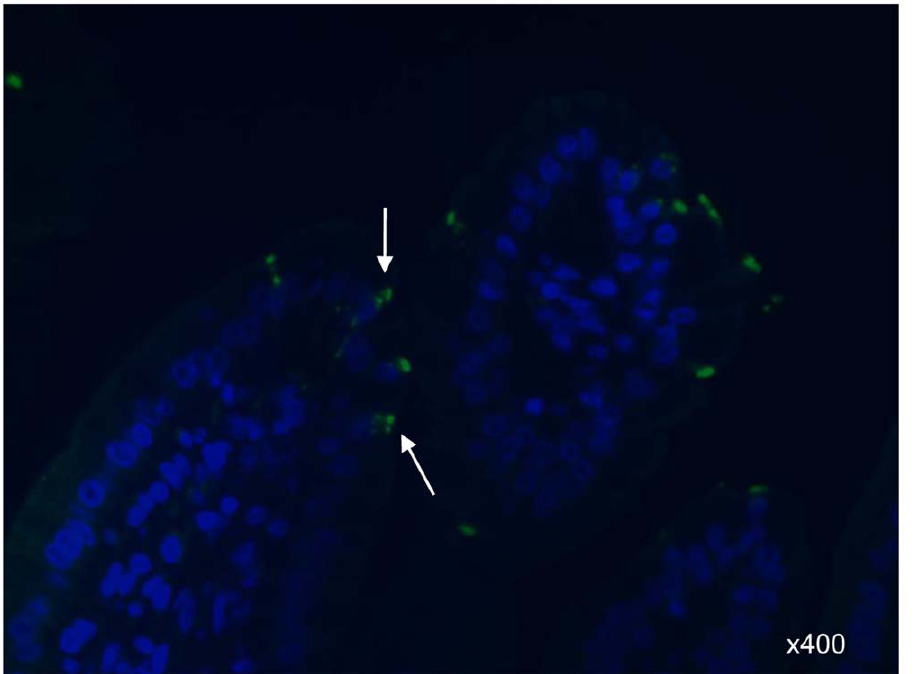
Figure 3. Fecal shedding coincides with IHC evidence for human NoV replication in the intestine. Jejunum of a Simvastatin + HuNoV pig at PID 3, showing viral antigens (arrows) in the cytoplasm of enterocytes. An IHC using guinea pig antiserum against the capsid protein VP1 of GII.4 HS194 HuNoV was used for detection of HuNoV antigen in formalin-fixed, paraffin-embedded tissues. Nuclei were stained with blue-fluorescent DAPI. Original magnification, x400.